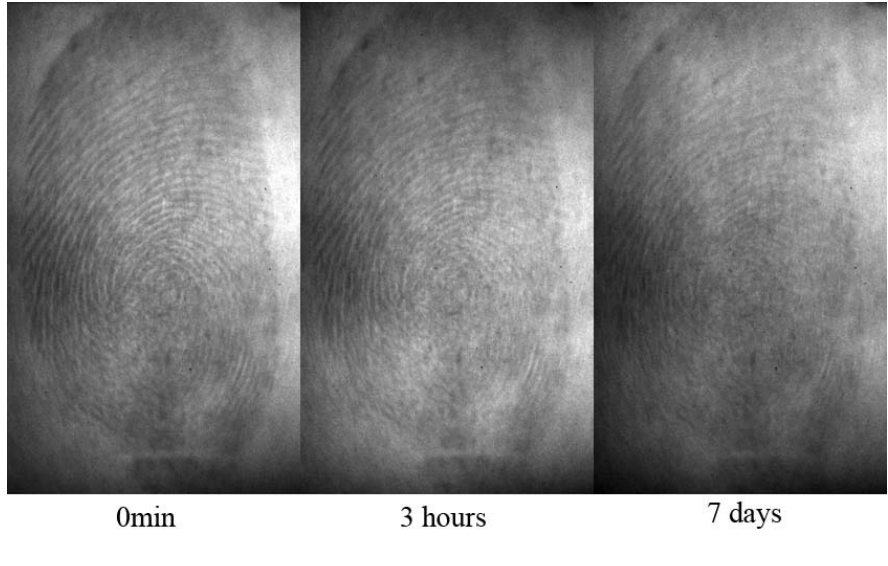
FIGURE 8. Time variation of absorption images of latent fingerprints on a HG white